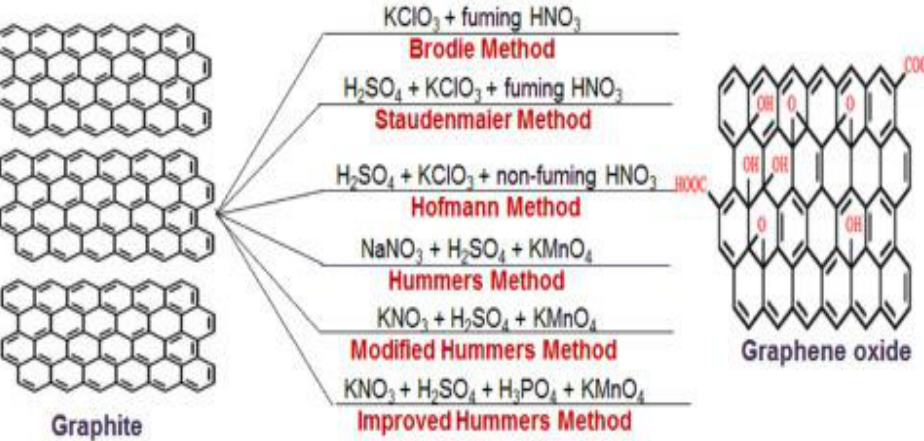
Figure 5. Graphene oxide synthesis by chemical oxidation using Brodie’s, Staudenmaier’s, Hofmann, and Hummer’s methods [27].